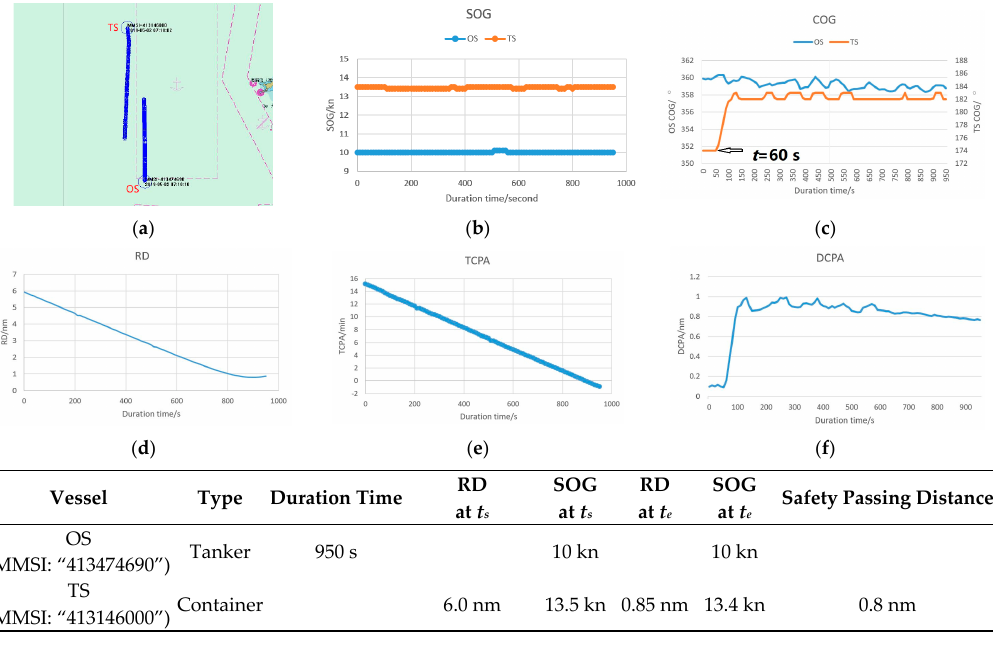
Figure 4. ‘head-on’ situation : ( a ) trajectory; ( b ) SOG; ( c ) COG; ( d ) RD; ( e ) TCPA; ( f ) DCPA; ( g ) sce- nario parameters aspects. Figure 5 presents a multi-ship encounter situation, where OS (container, MMSI: “412713000”) encounters TS1 (tanker, MMSI: “412377520”) in a head-on situation, OS (give-way ship) and TS2 (cargo vessel, MMSI: “413700110”), TS3 (tanker, MMSI: “413441230”), TS4 (tanker, MMSI: “413697340”), respectively, meet under crossing en- counter rules and OS (stand-on ship) and TS5 (cargo vessel, MMSI: “412766340”, give- way ship) meet in a overtaking encounter situation. Figure 5d indicates that RD ( t = 0 s) between OS and TS1, TS2, TS3, TS4 are, respectively, 3.5 nm, 4.4 nm, 1.9 nm and 2.2 nm. Therefore, the OS, TS3, and TS4 are in the close-quarter situation. As shown in Figure 5a,